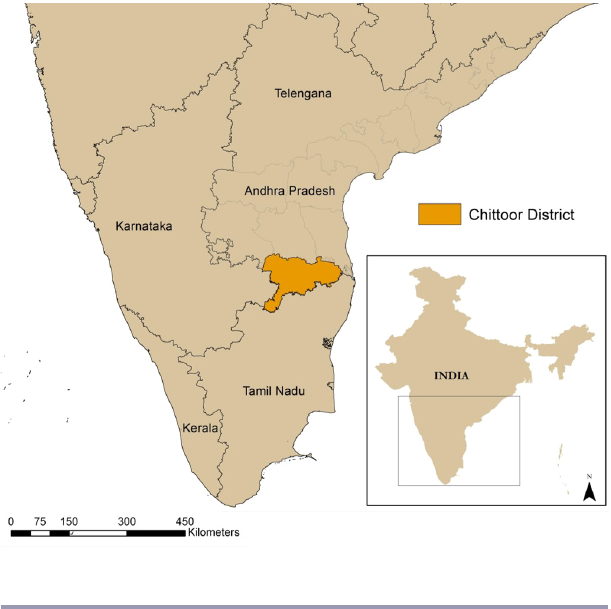
Fig. 1. Map showing the location of Chittoor District, Eastern Ghats,